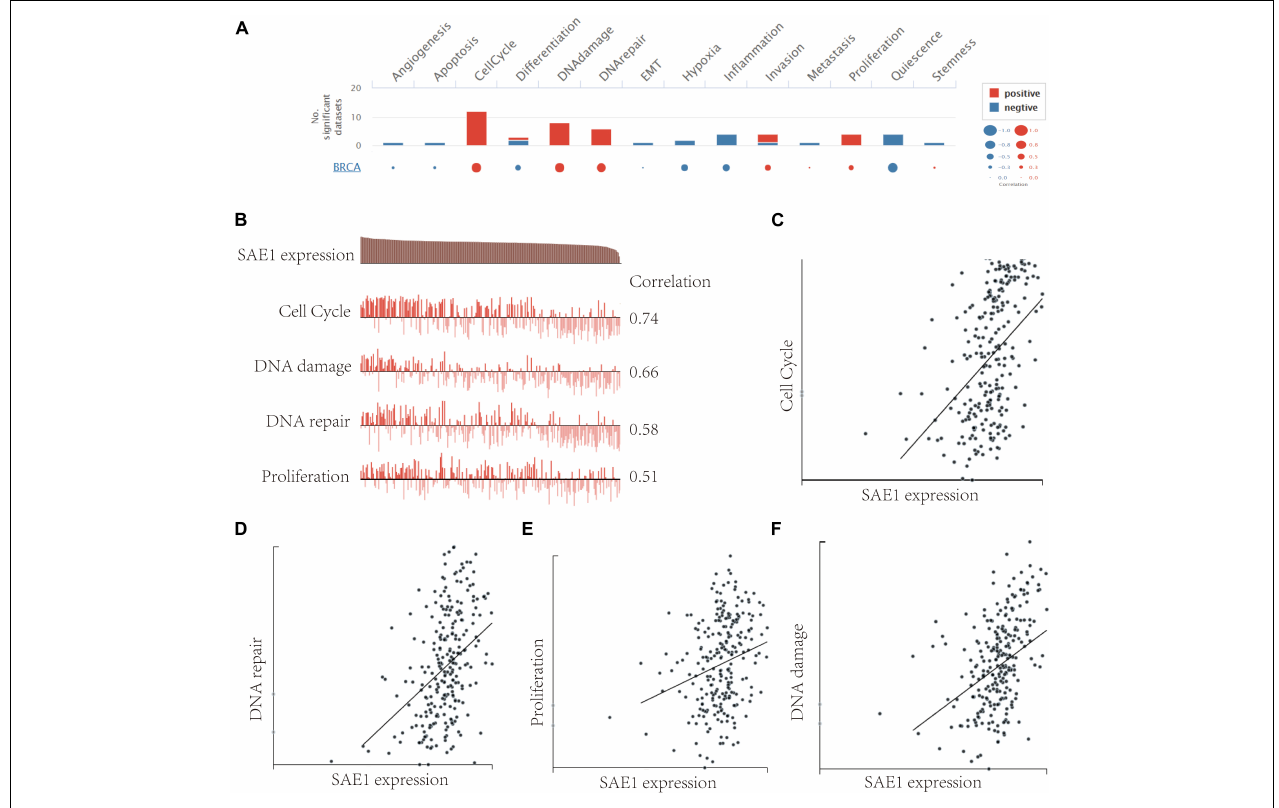
FIGURE 5 | The function of SAE1 in breast cancer cells. (A) Single-cell analysis displayed the correlation between SAE1 and 14 functional states (including angiogenesis, apoptosis, invasion, EMT, differentiation, proliferation, DNA damage, metastasis, hypoxia, inflammation, cell cycle, DNA repair, stemness, and quiescence). (B) Single-cell analysis indicated that SAE1 is primarily involved in regulation of the cell cycle, DNA damage and repair, and proliferation in breast cancer. (C) Correlation between SAE1 expression and cell cycle. (D) Correlation between SAE1 expression and DNA repair. (E) Correlation between SAE1 expression and cell proliferation. (F) Correlation between SAE1 expression and DNA